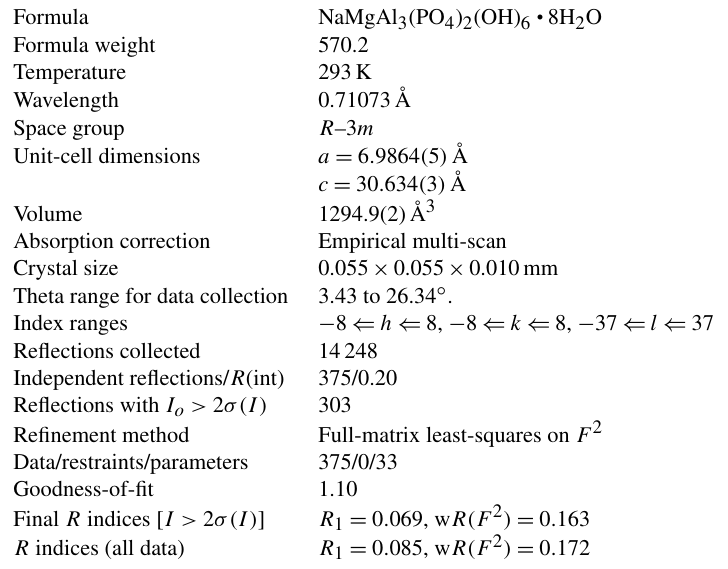
Table 3. Crystal data and structure refinement for tomsquarryite.